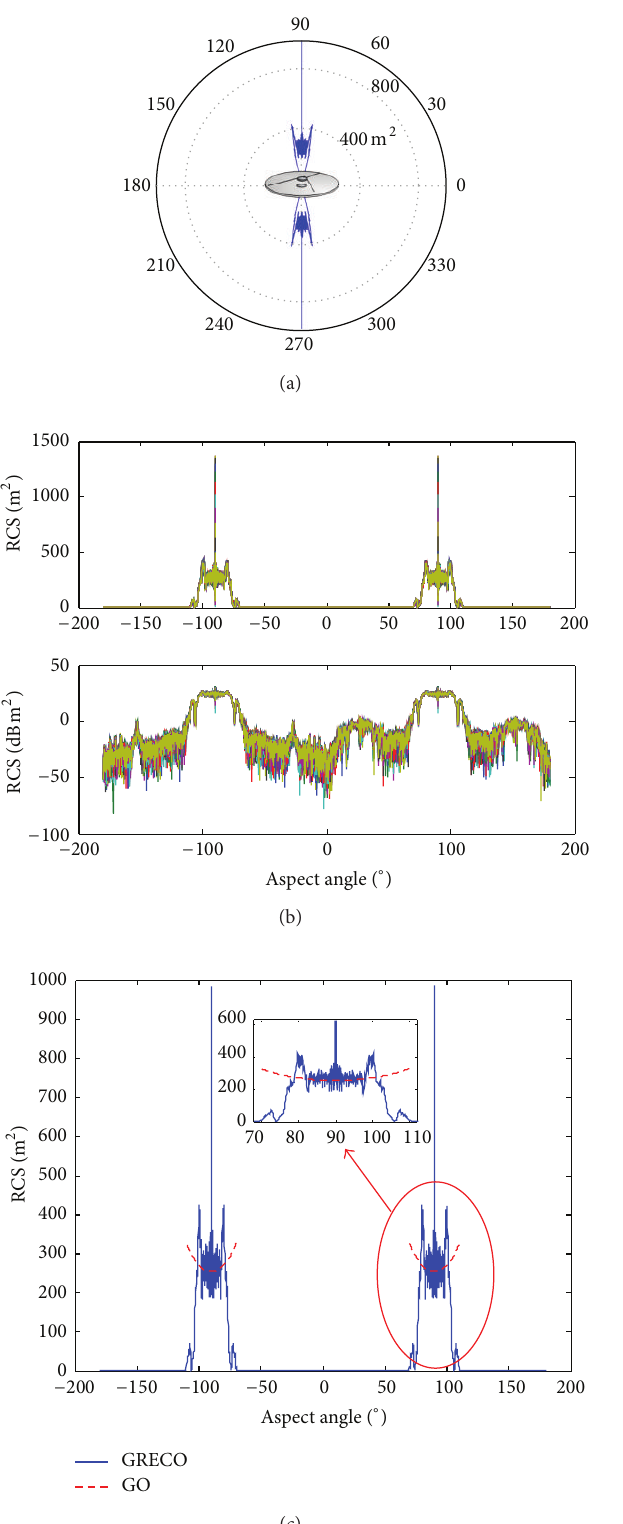
Figure 4: PRA RCS’s aspect dependency. (a) GRECO, at carrier frequency 10GHz; (b) GRECO, at different frequencies; (c) GRECO and GO, at carrier frequency 10GHz.